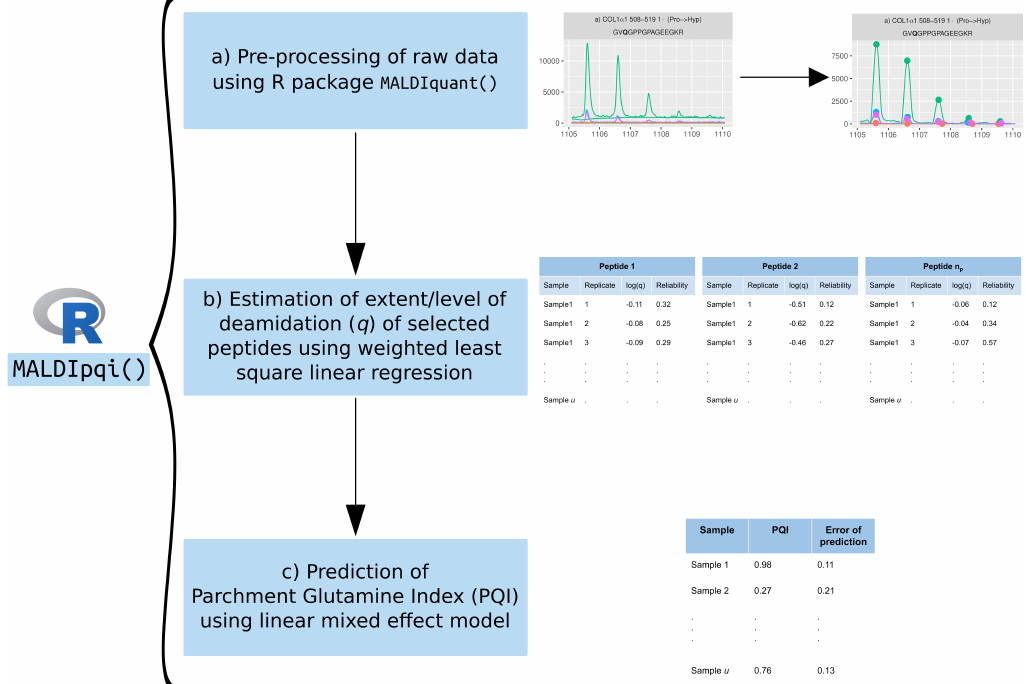
Figure 2. Summary of the workflow developed as an R package MALDIpqi . MALDIpqi consists of three steps, a) pre-processing of MALDI-TOF spectra, b) estimation of q of selected peptides, and c) prediction of